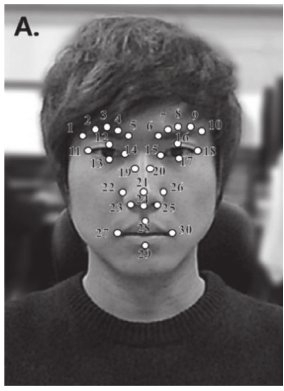
Figure 2: Facial analysis points used for facial expression